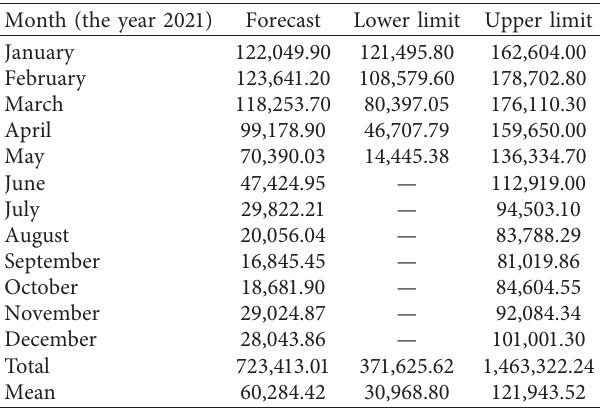
Table 2: Forecast malaria cases for 2021 in the northwestern province, Zambia.